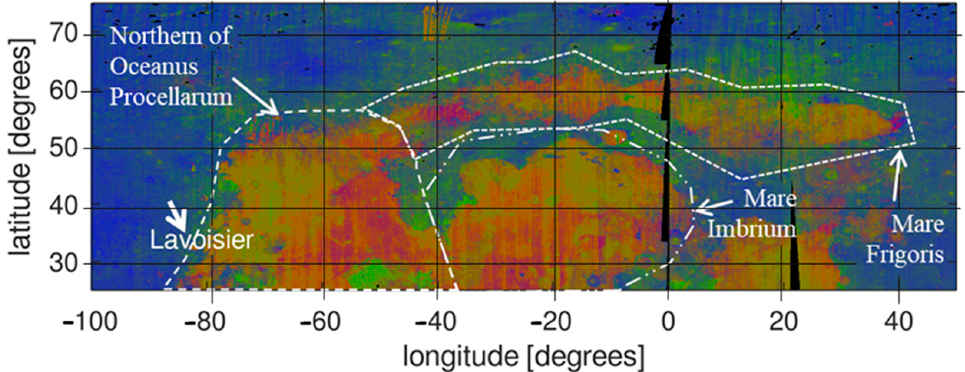
Figure 12. Petrological map of Mare Frigoris, northern Oceanus Procellarum, and northern Mare Imbrium. Mare basalt areas appear in red/orange color. The northern Imbrium Noritic anomaly [68] corresponds to the green area surrounding Mare Frigoris. This noritic area extends to the west until the northern and northwestern rims of Oceanus Procellarum and transitions into the Lavoisier region.